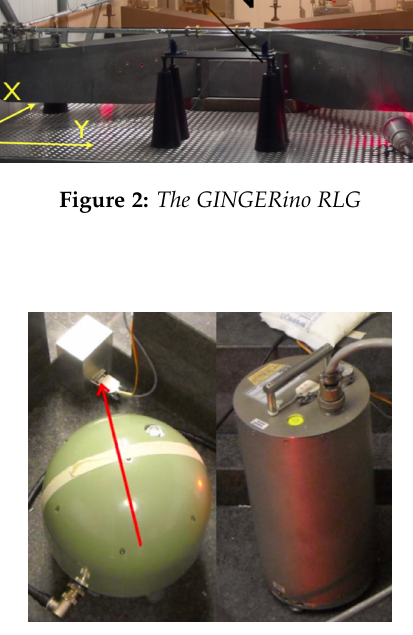
Figure 3: The NANOMETRICS Trillium 240 s (left) and Guralp CMG 3T360s (right) and the Lipp- mann 2-K tilt meter (on top), the red arrow shows the North direction This instrument is also part of the national earthquake monitoring program of the Istituto Nazionale di Geofisica e Vulcanolo- gia (INGV hereinafter; see also the URL